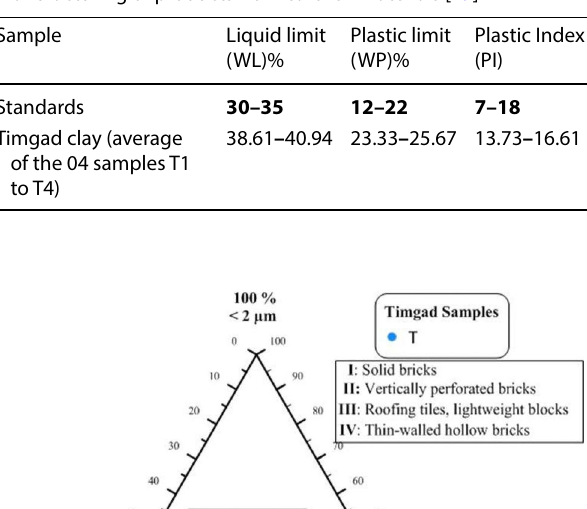
Table 6 Ranges of Atterberg limits required for clay bricks by the manufacturing of products from earthen materials [29]